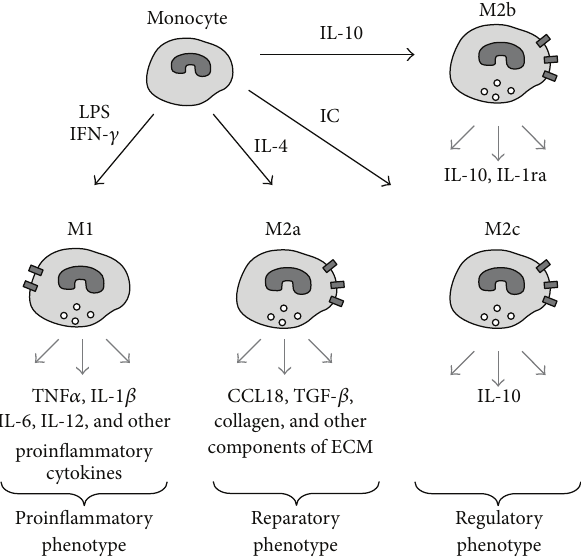
Figure 1: Simplified scheme of macrophage polarization. Activation of monocytes is followed by the polarization of macrophages to acquire proinflammatory phenotype (M1) or anti-inflammatory phenotypes (M2a–M2c) depending on the activation stimuli. Each phenotype is characterized by the secretion of a distinct pattern of pro- or anti-inflammatory cytokines and other molecules. For instance, M1 macrophages release TNF 𝛼 , IL-1 𝛽 , IL-6, IL-12, and other proinflammatory cytokines, whereas M2a macrophages pro- duce CCL18, TGF- 𝛽 , collagen, and other extracellular matrix com- ponents. LPS:bacterial lipopolysaccharides; IC:immunecomplexes; IFN- 𝛾 : interferon gamma; IL: interleukin; TNF 𝛼 : tumor necrosis factor-alpha; TGF- 𝛽 : transforming growth factor beta; CCL18: CC chemokine ligand